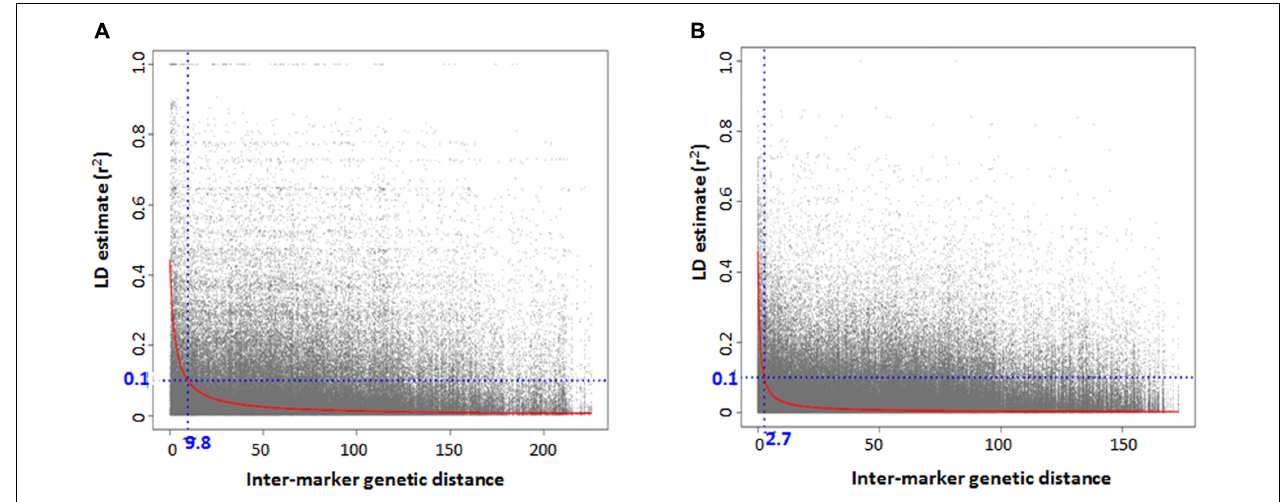
FIGURE 4 | Genome-wide linkage disequilibrium (LD) decay plot for Aegilops tauschii accessions belonging to (A) lineage 1 and (B) lineage 2.